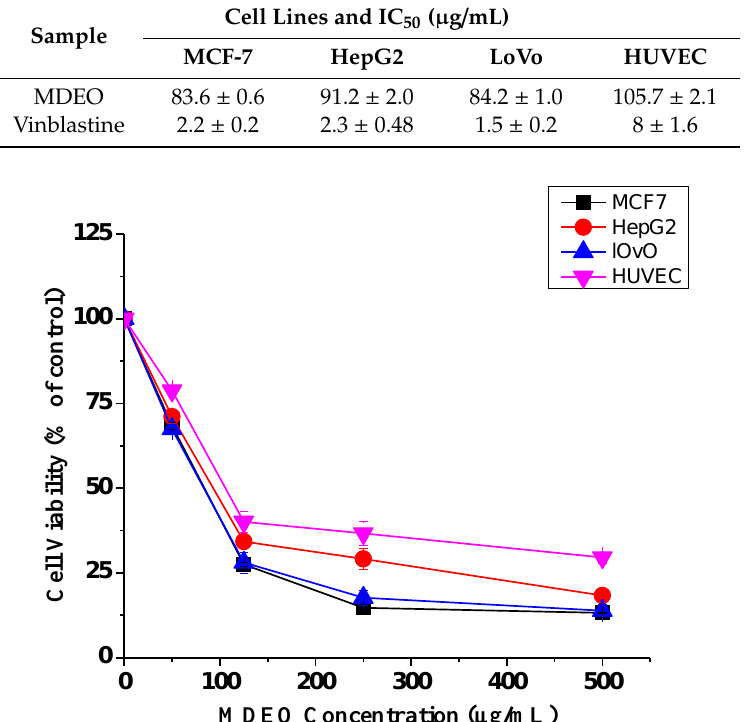
Figure 3. Detection of apoptosis by phase contrast and fluorescence microscopy in cells after treatment with MDEO. MCF-7 cells were treated with IC 50 for 24 h. Cells were stained with DAPI, acridine orange, and ethidium bromide (AO/EtBr).